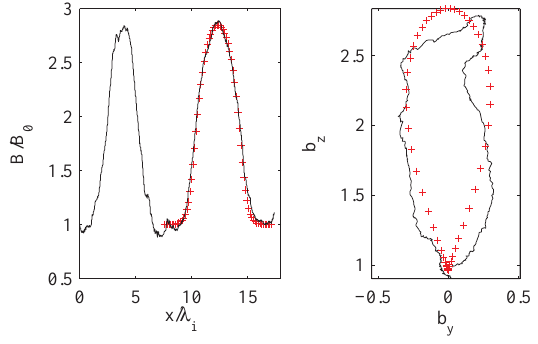
Fig. 7. Relation between the density n = N/N 0 and the mag- netic field b = B/B 0 implied by Eq. (A1), computed for two betas: β ⊥ =11 (red) and β ⊥ =2 (blue) lines. Other parameters are: M =0.1, cos α =0.27, γ =1.60, κ =0.10, γ a = − 0.62, κ a = − 0.25, a p 0 =0.714.